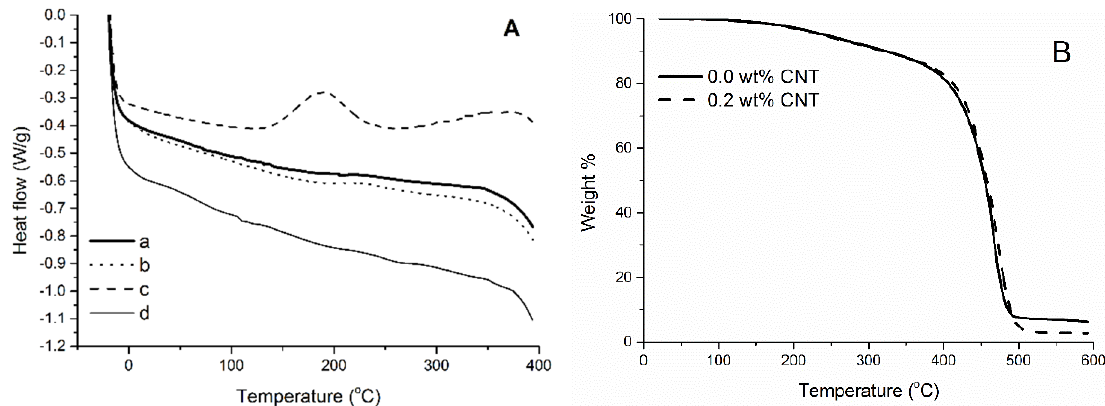
Figure 6. ( A ) DSC curves of: (a) unreinforced tung oil-based resin cured for 6 h at 140 °C in a convection oven, (b) tung oil-based resin reinforced with 0.2 wt % of CNTs and cured for 6 h at 140 °C in a convection oven, (c) a tung oil-based resin reinforced with 0.25 wt % CNTs microwaved at 100 W for 10 min, followed by 200 W for 10 min, and (d) a tung oil-based resin reinforced with 0.25 wt % CNTs microwaved at 100 W for 10 min, followed by 200 W for 10 min, and a 2 h 10 min post-cure step at 140 °C in a convection oven; ( B ) TG curves of tung oil-based resins cured for 6 h at 140 °C in a convection oven with and without